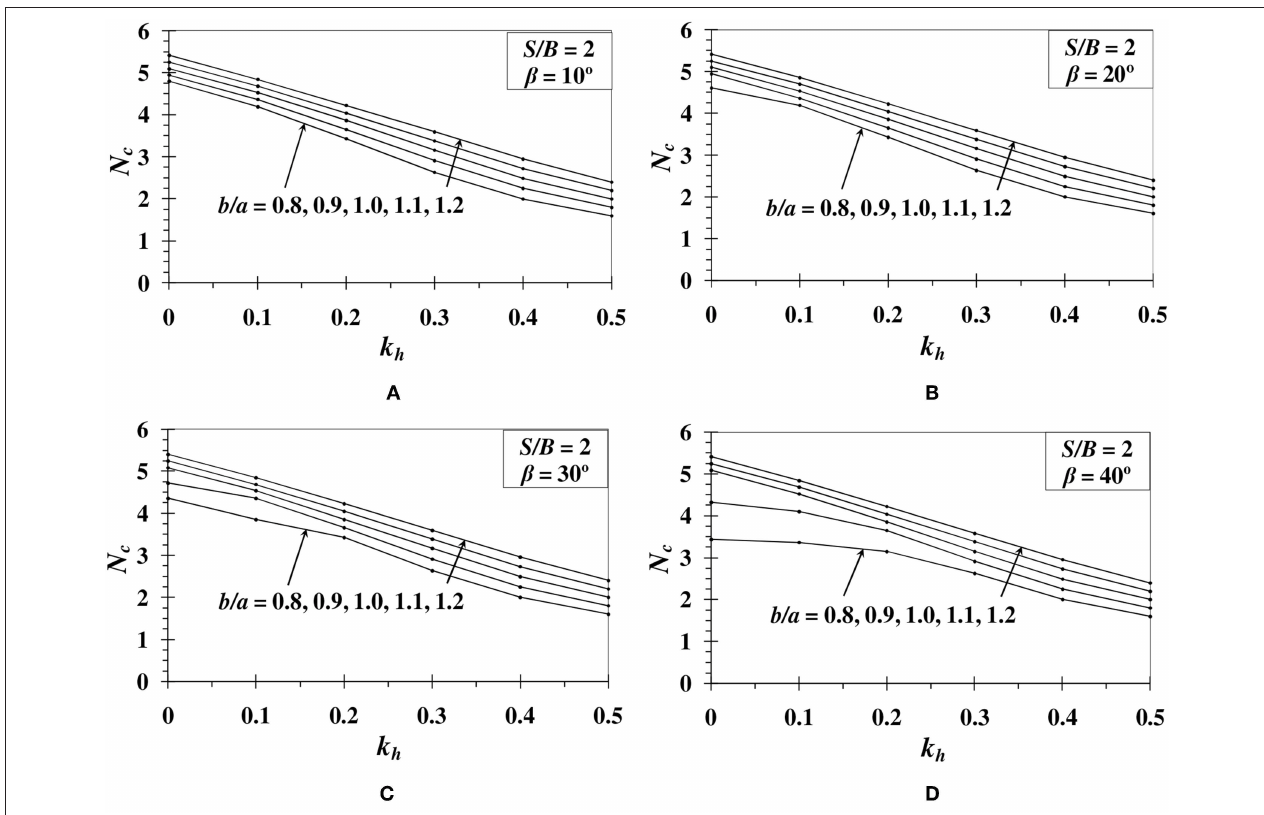
FIGURE 3 | Variation of N c with respect to k h for S/B